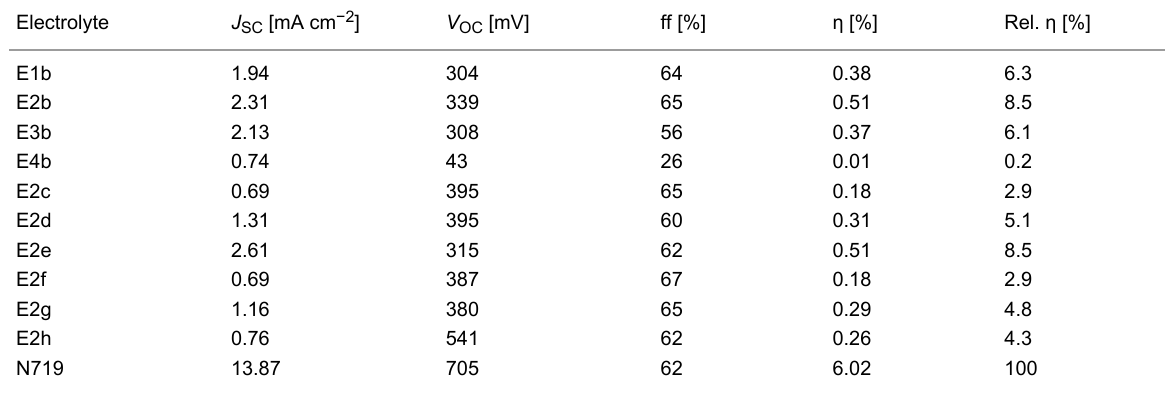
Table 4: Parameters for masked DSCs using different additives and additive concentrations (see Table 3) in the electrolytes. Measurements were made on the day of sealing the cell. See Table S2 and Table S3 (Supporting Information File 1) for multiple cell data. Electrolyte J SC [mA cm − 2 ] V OC [mV] ff [%] η [%] Rel. η [%]